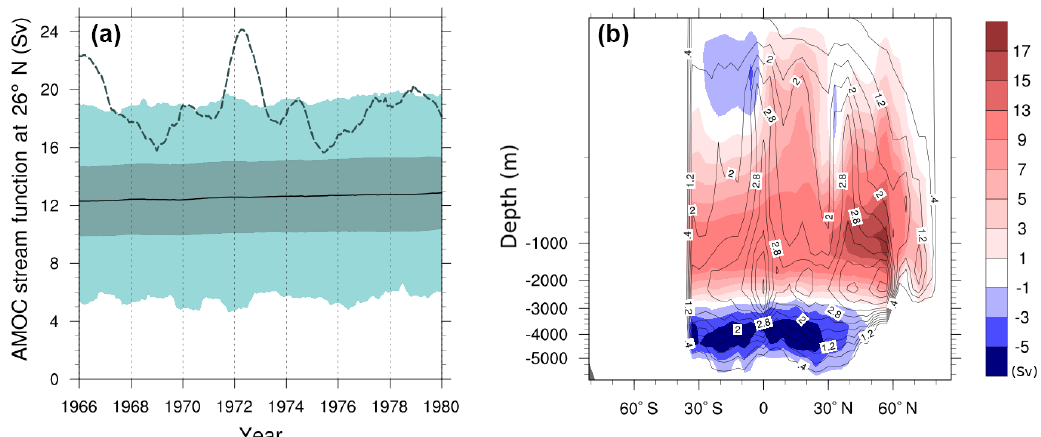
Figure 15. (a) Maximum AMOC strength at 26 ◦ N between 1966 and 1980CE. The black solid line represents the ensemble mean; the dark blue area represents the ensemble mean ± one standard deviation; the light blue area is bounded by the simulations with the maximum and minimum AMOC strength (time averaged); and the dashed line represents ORA-S3 (Balmaseda et al., 2008). (b) , AMOC stream-function mean (filled colours) and ensemble standard deviation (contour